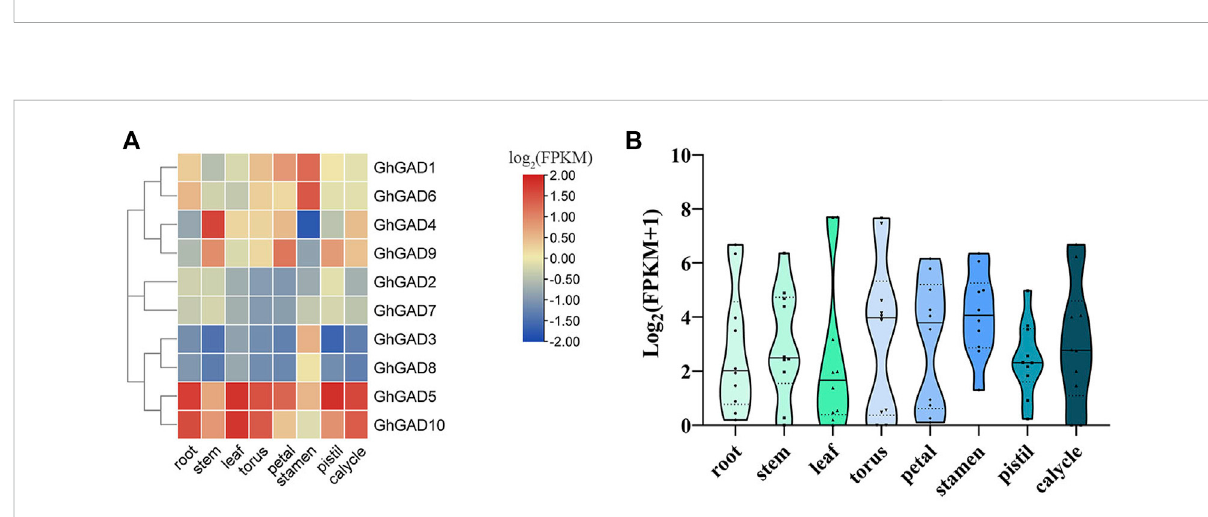
FIGURE 7 GhGAD genes display tissue-differential expression under normal conditions. (A) The color represents the gene expression values of RPKM of GhGAD genes transformed by log 2 . (B) The expression distribution of all GhGADs in each